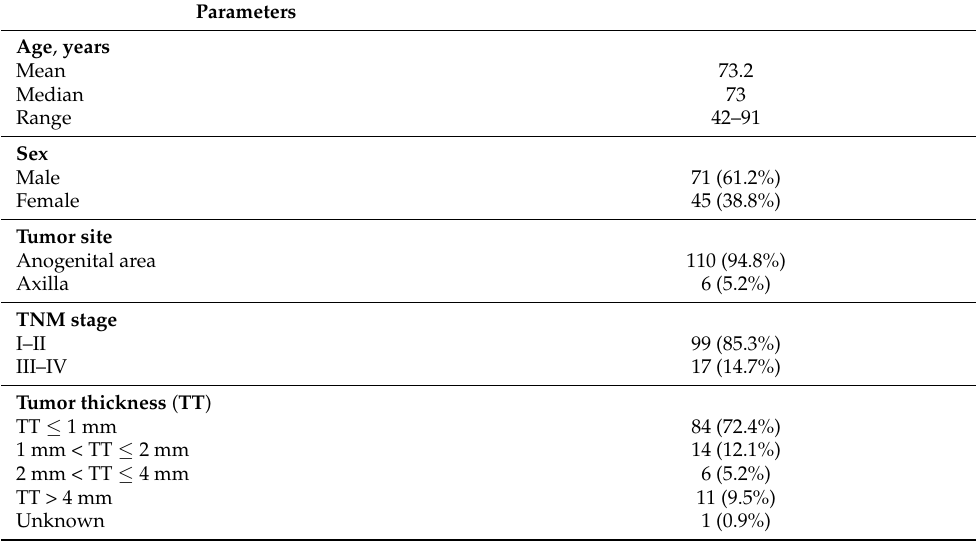
Table 1. Demographic data of 116 patients with primary extramammary Paget’s